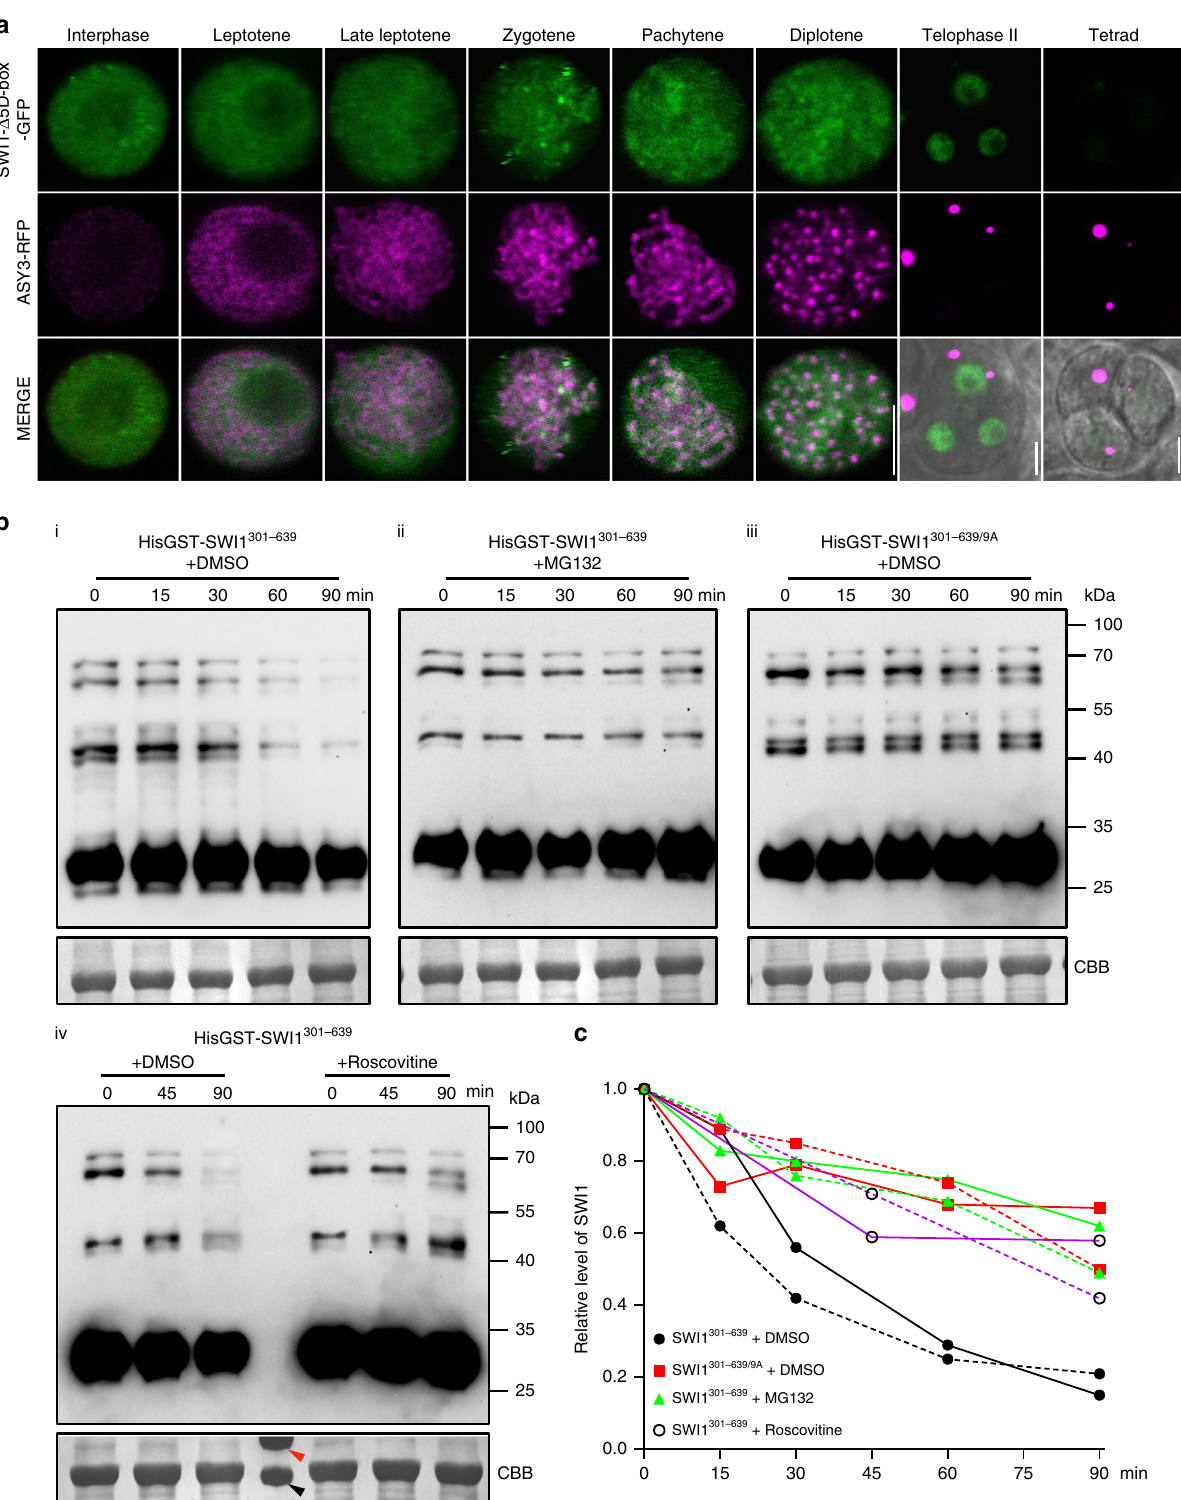
Fig. 9 APC/C-mediated degradation of SWI1. a Deletion of the fi ve predicted destruction boxes (D-box) in SWI1 (SWI1- Δ 5D-box-GFP) results in prolonged occupancy along chromatin in comparison with SWI1-GFP (Fig. 2a). ASY3-RFP is shown for staging. Bar: 5 μ m. b Cell free degradation assay of HisGST- SWI 301-639 and HisGST-SWI 310-639 in the presence of DMSO (solvent control), 50 μ m MG132, or 5 μ m Roscovitine. The source data of the uncropped immunoblots are provided in the Source Data fi le. c Relative protein level of SWI1 according to b . The intensity of all bands between 100 and 40 kDa was measured and plotted on the graph. The solid lines represent the relative protein level of SWI1 shown in b and the dashed lines depict the results of the second biological replicate. The large subunit of Rubisco stained by CBB veri fi es the equal loading of the samples. The red and black arrowheads indicate the protein marker at 70 and 55 kDa,